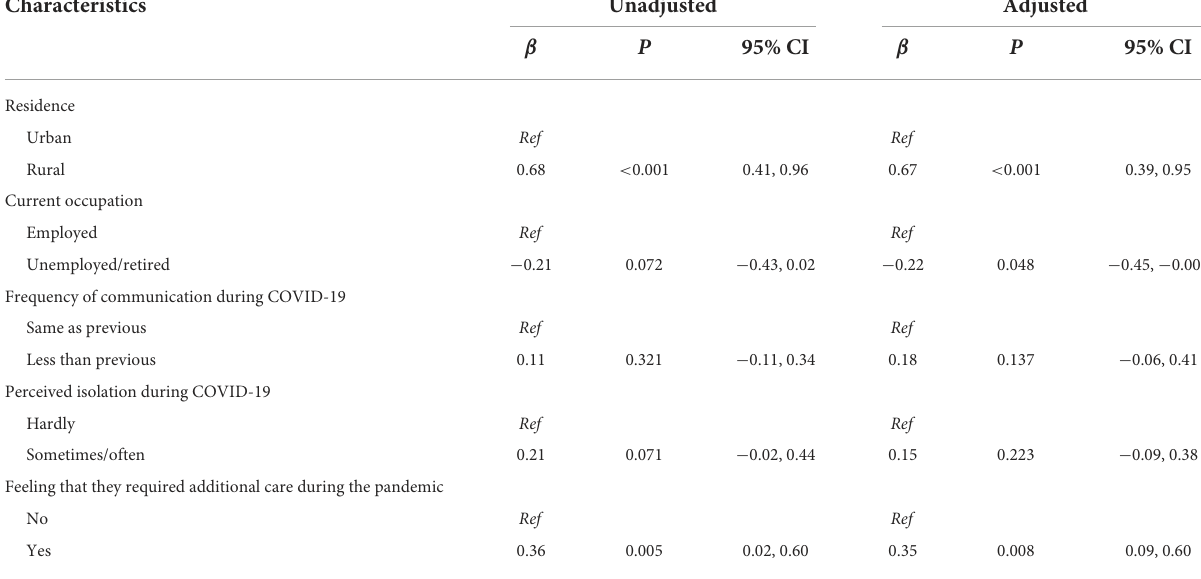
TABLE 3 Factors associated with stigma among the participants ( N = 1,045).